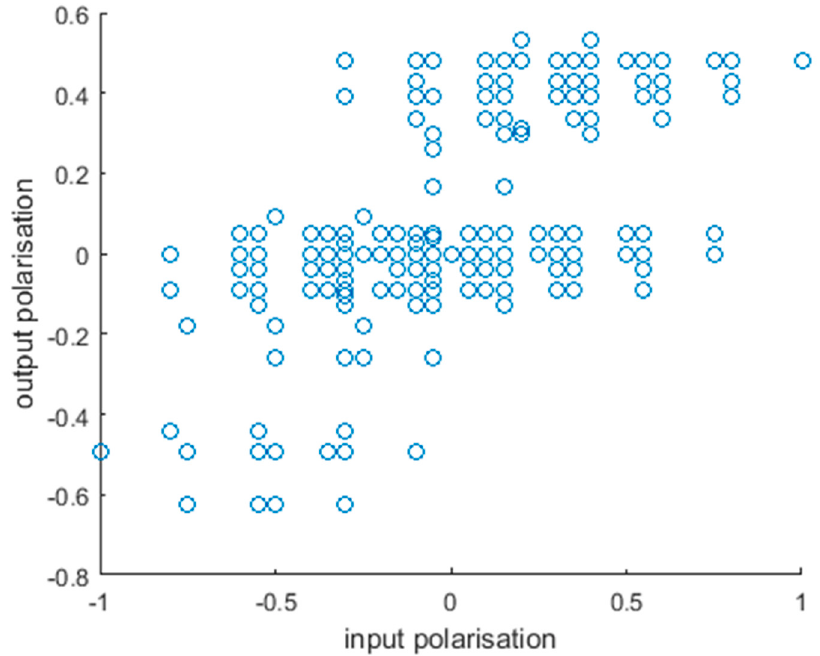
Figure 3. Alignment of input and output polarization. Each point represents an input combination. While input polarization does not translate directly to the output, there is a clear correlation between the two, further supporting that our model is in line with our understanding of the effects of these factors.